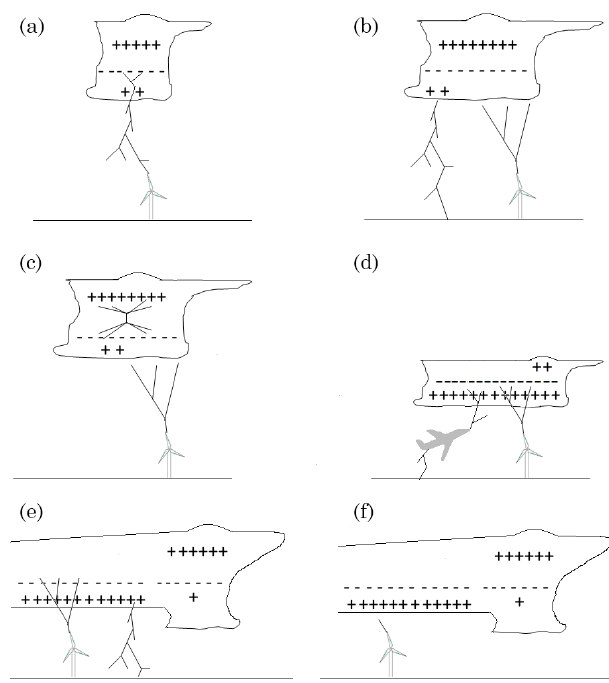
Figure 1. (a) Downward lightning stroke to a wind turbine; (b) up- ward lightning initiated by a nearby CG flash; (c) upward lightning initiated by a IC flash; (d) upward lightning from a wind turbine and lightning initiated by aircraft in a winter storm (charge distri- bution as observed winter storms in Japan); (e) upward and down- ward positive flashes in the trailing stratiform of MCS; (f) repetitive corona/leader emissions from wind turbines under storms. Propor- tions in these diagrams are not to